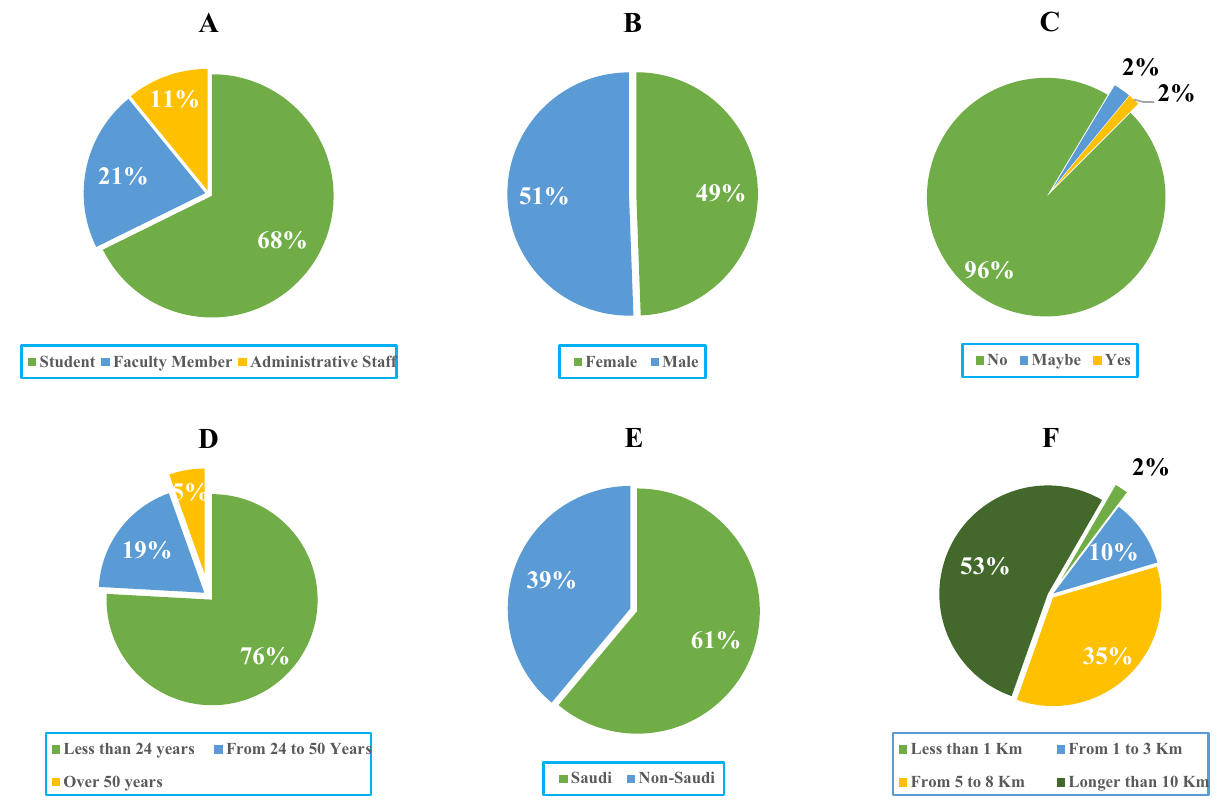
Figure 3. Main characteristics of the respondents (N = 257). ( A ) Role in the University. ( B ) Gender. ( C ) Physical disability. ( D ) Age. ( E ) Nationality. ( F ) Distance to the